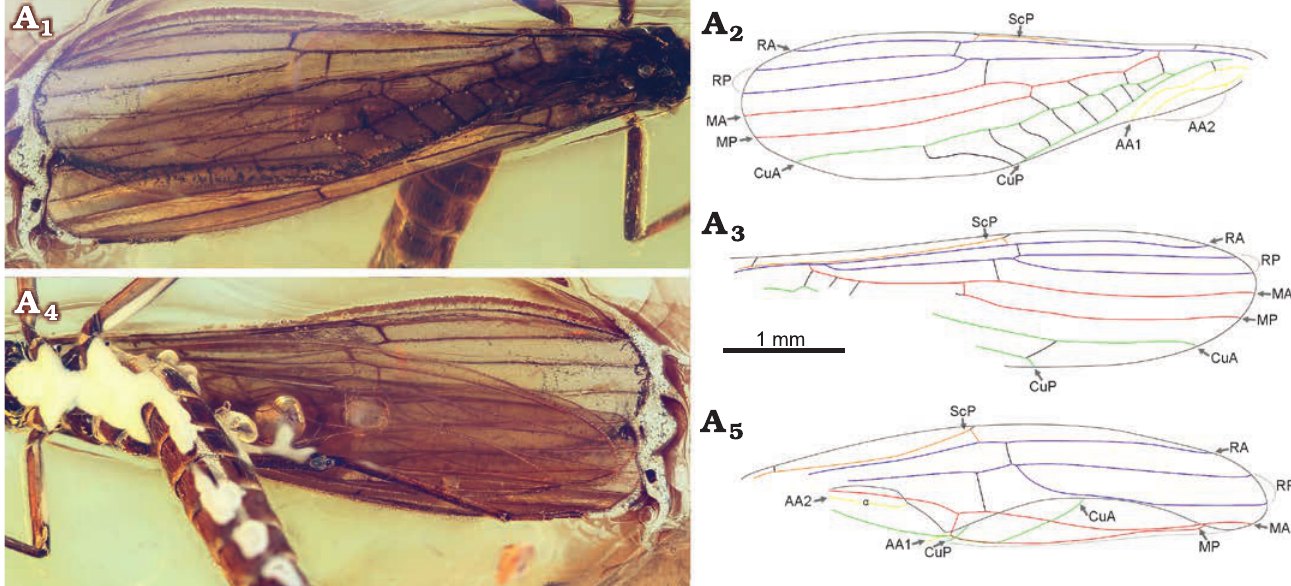
Fig. 2. Needle stonefly Baltileuctra dewalti Chen sp. nov. (holotype, ICJUST CZT-PLE-BA8) from Eocene Baltic Amber from unknown locality in Lith- uania. Male adult, left (A , A ) and right (A ) forewings in dorsal view, left hind wing in ventral view (A 1 2 3 drawings (A , A , A 2 3 5